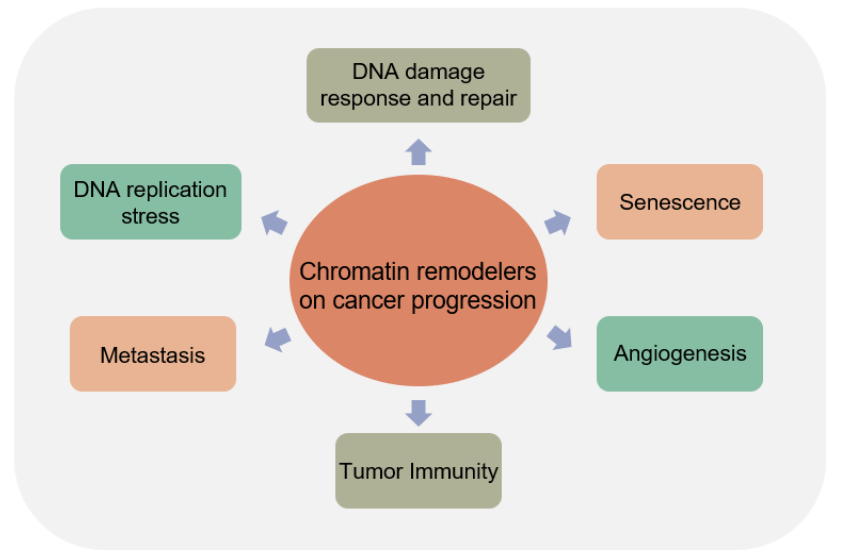
Figure 3. Effects of chromatin remodeler deregulation on cancer progression. Dysregulation of chromatin remodelers impact cancer progression through cellular processes such as DNA damage response and repair, DNA replication stress, senescence, metastasis, angiogenesis, and tumor